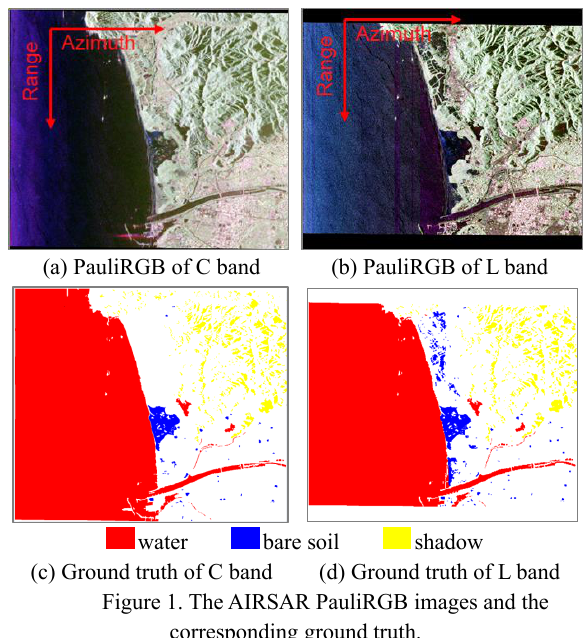
Figure 1. The AIRSAR PauliRGB images and the corresponding ground truth.